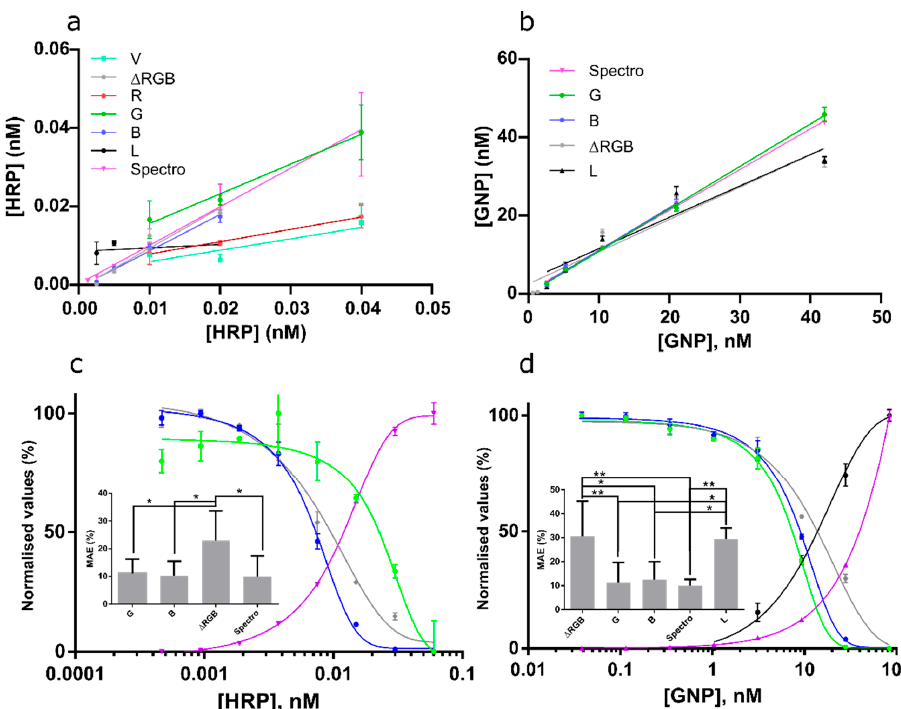
Figure 9. ( a ) Linear regression functions for oxidation of tetramethylbenzidine (TMB) with horseradish peroxidase (HRP) in ELISA wells for the smartphone analyses using various channels and a benchtop ELISA plate spectrometer. ( b ) Linear regression functions for colloid GNP at various concentrations in ELISA wells for the smartphone analyses using various channels and a benchtop ELISA plate spectrometer. Color codes and channels used are indicated. ( c , d ) normalized four-parameter dose-response curve fits for HRP oxidation of TMB ( a ) and colloid GNP ( b ) in ELISA wells. Green and blue circles stand for G and B channels, grey diamonds ∆ RGB, magenta triangles absorption values measured by a spectrometer. ( c , d inset) MAEs calculated from the predictions shown in ( a , b ). Stars indicate p -values from post-hoc analyses with p -value correction for multiplicity. * = p < 0.05, ** = p < 0.01. Table 6. Analytical parameters of prediction and calibration curves for GNP and TMB solution ELISA. R 2 and slopes given for prediction curves are from linear regression lines. All calibration curves were prepared using four-parameter dose-response functions. LOD, linear range, and IC 50 values were interpolated from the normalized calibration curves at 90%, 80%–20%, and 50% for R, G, B, and ∆ RGB channels and 10%, 20%–80%, and 50% for spectrometer values, respectively.